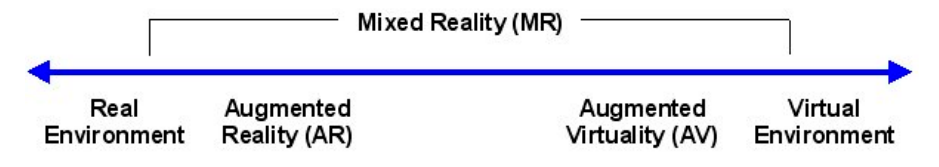
Figure 1. The types of realities, from real to virtual [4].